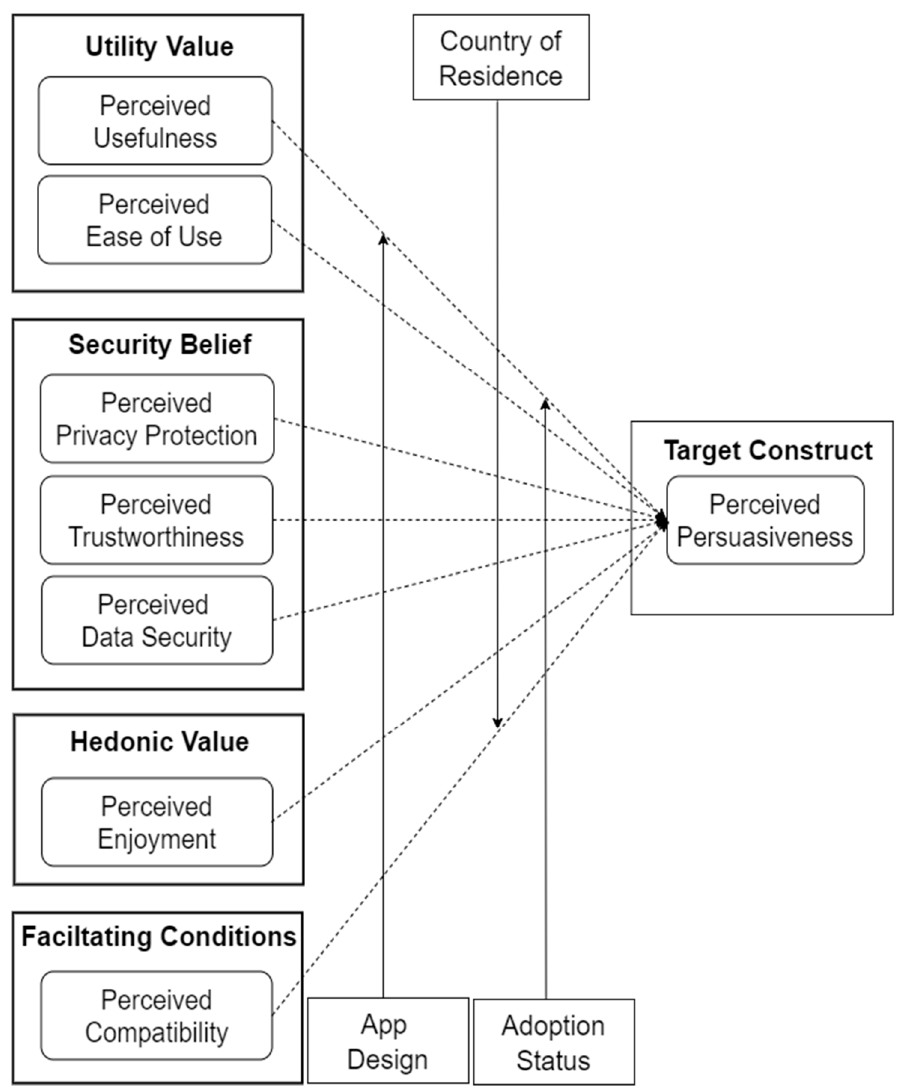
Figure 4. Research model.